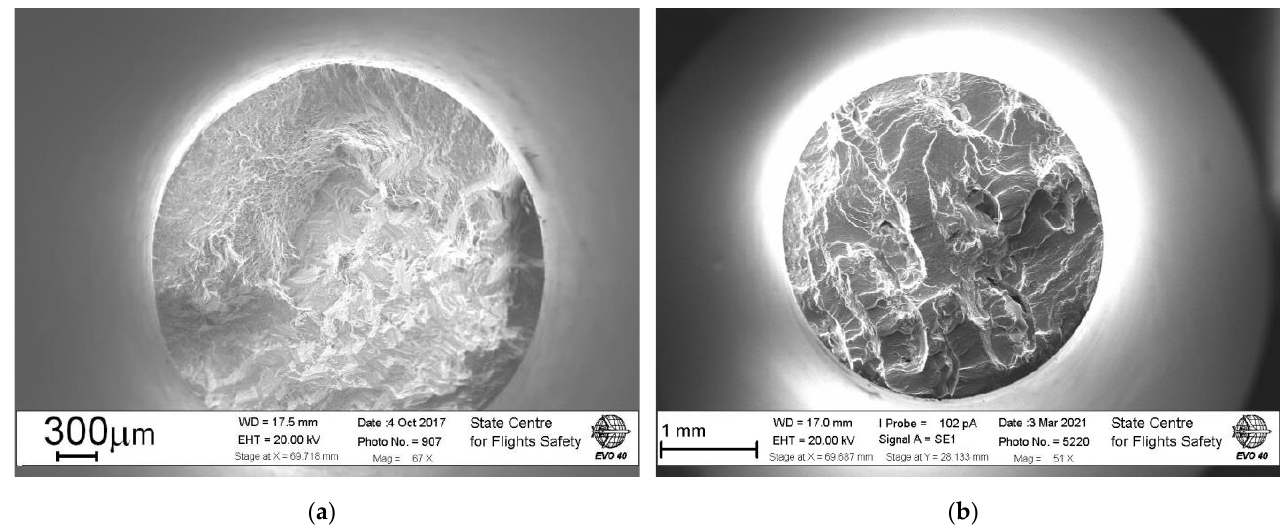
Figure 8. The typical fracture surfaces of hot-rolled ( a ) and SLM ( b ) specimens.